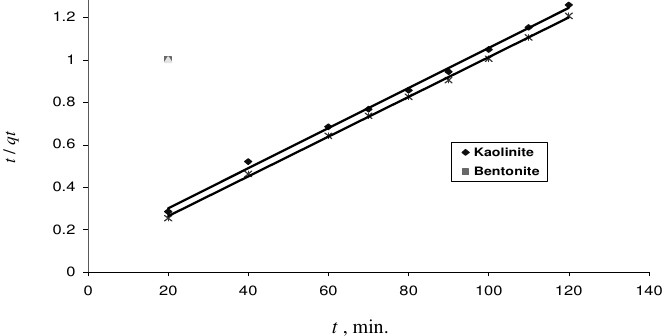
t , Figure 7. Time profile and pseudo second order kinetics model for manganese(II)